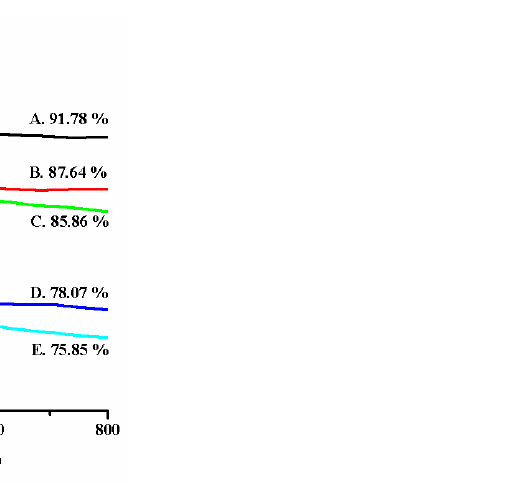
Figure 6. TG curves of GdPO 4 · H 2 O@SiO 2 (A) and the modified products synthesized with different proportions of GdPO 4 ·H 2 O@SiO 2 –APS:NCA = 1:0.125 (B), 1:0.25 (C), 1:0.5 (D) and 1:1 (E).